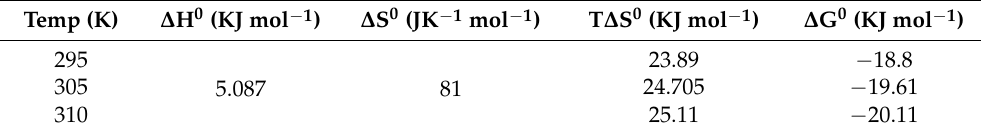
Table 3. Various thermodynamic parameters for QTP-HSA complex formation at various temperatures.